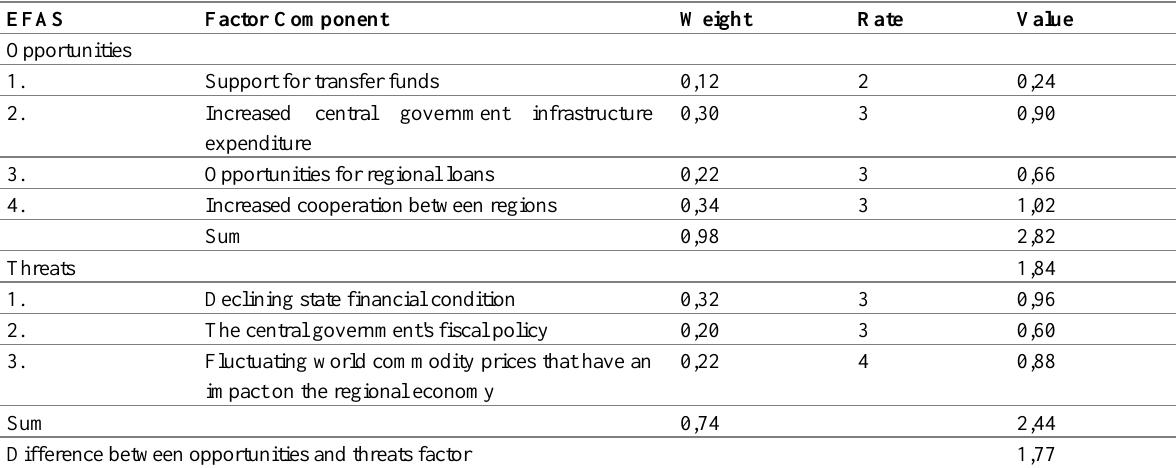
Table 3: Analysis Result of External